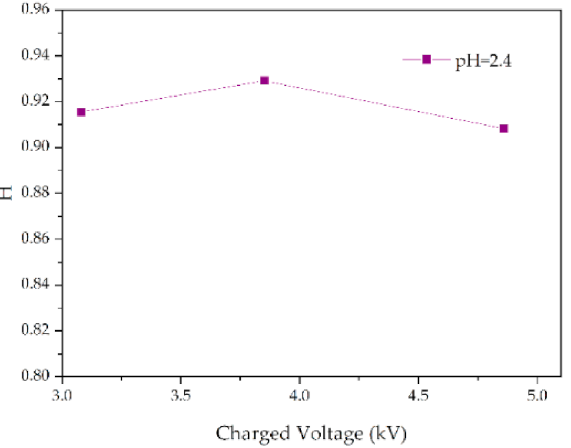
Figure 14. Changes in H values of samples with charged voltage (pH = 2.4, t = 8 h).